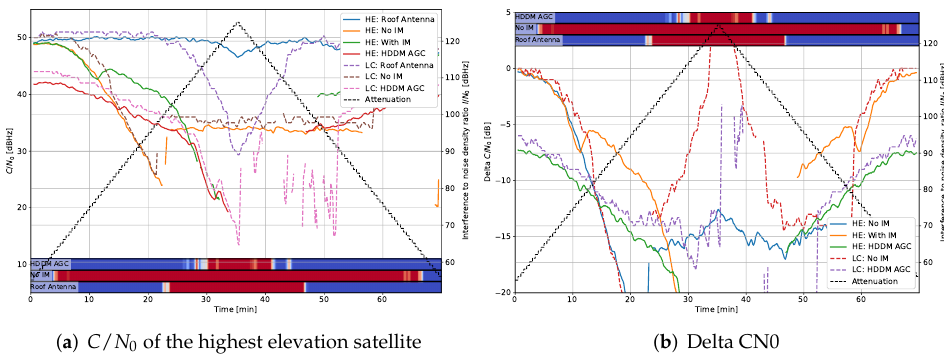
Figure A11. Interference #2: Fast Chirp 10 MHz with Galileo E1BC.